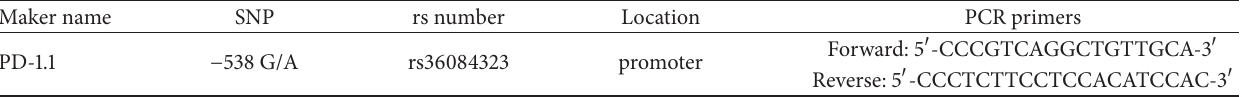
Table 1: Primers of SNP PD-1.1 used for